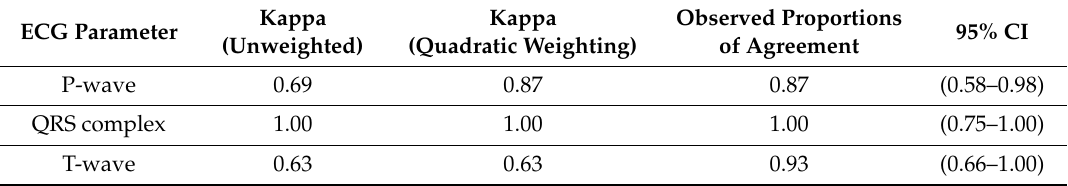
Table 3. Interobserver agreement for accurate ECG morphology of